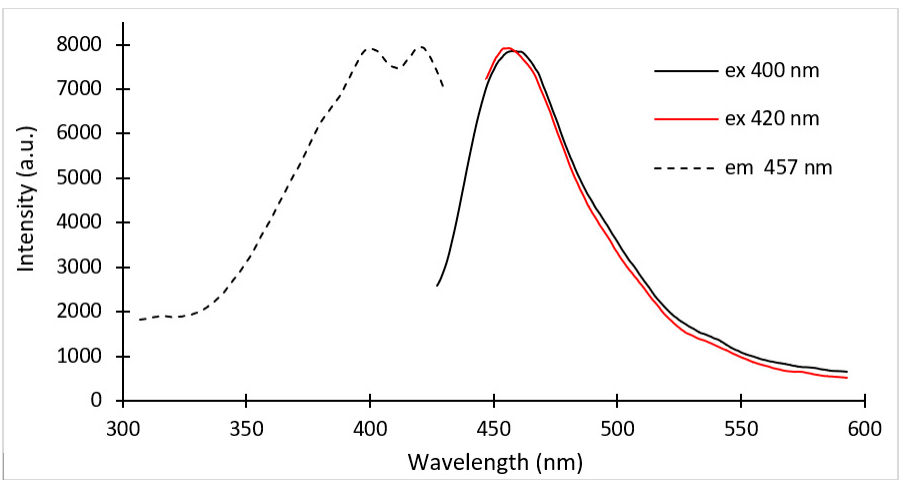
Figure 9. Fluorescence spectra of 3 wt% DIPA in silicone oil at room temperature in a 2 mm (optical path) flattened pyrex capillary. Emission wavelengths ( λ em = 457 nm; black, dotted line) and excitation wavelengths ( λ ex = 400 nm; black, solid line and 420 nm; red, solid line). The capillary was placed at a 45° angle with respect to the incident beam and the detector direction (transmission).